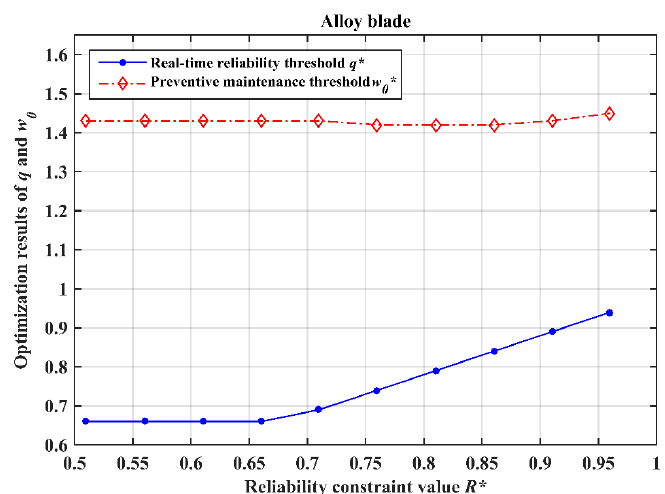
Figure 16. Sensitivity analysis of the effects of the reliability constraint value 𝑅 ∗ on the optimal values q ∗ and w ∗ 0